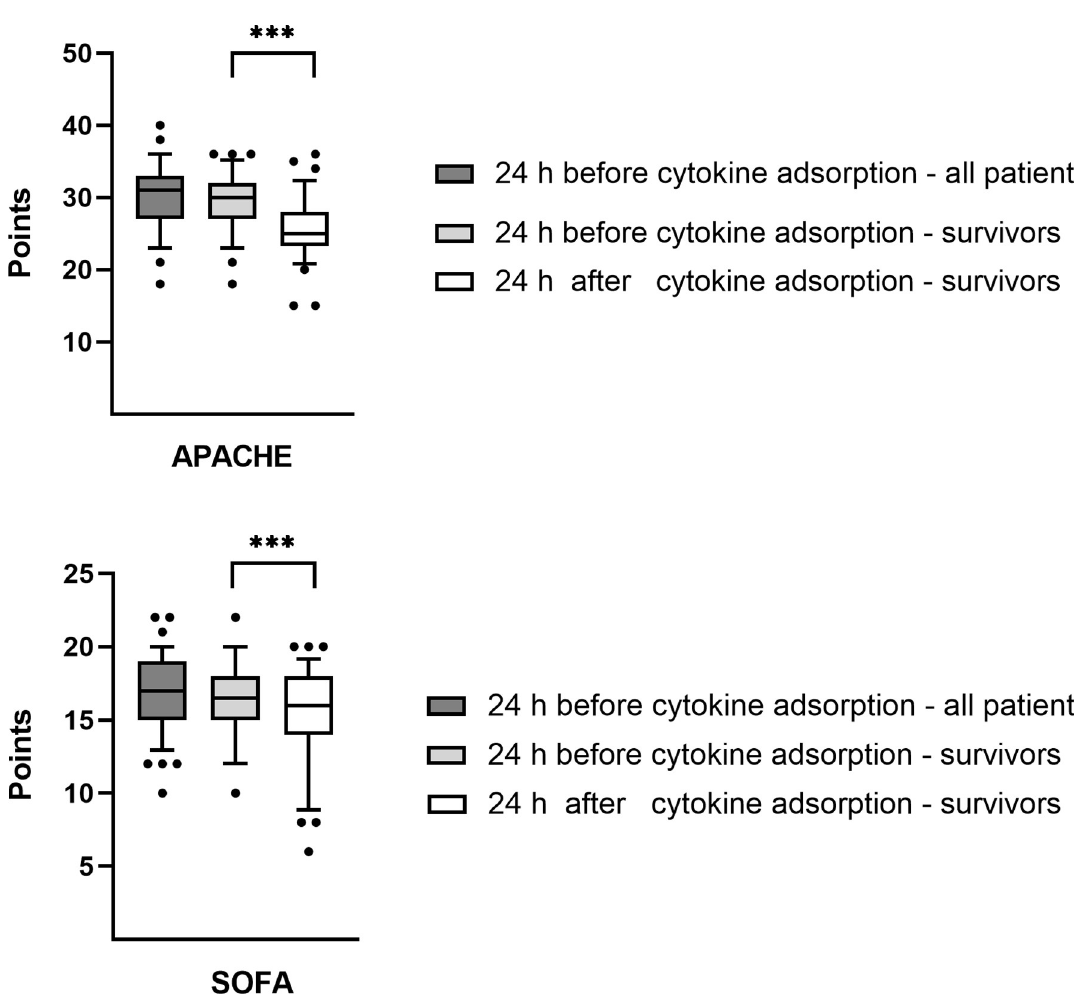
Fig 5. SOFA- score (Fig 5A) and APACHE II-score (Fig 5B) before and after cytokine adsorption. First box shows all n = 98 patients analysed in the study. Second and third box show n = 76 patients who survived longer than 24 hours after cytokine adsorption. Central lines denote median values, and upper and lower borders represent 25th and 75th percentiles. The whiskers represent 5–95 percentile. Highest and lowest values are marked as dots. Asterisks mark differences between both groups at a significance ��� p < 0.001. https://doi.org/10.1371/journal.pone.0246299.g005 SOFA- and APACHE II-score were significantly decreased after cytokine adsorption and the observed in-hospital mortality rate was lower than SOFA- and APACHE II-score predicted mortality rate. In these patients with a predicted very high mortality risk according to Euro- SCORE II, SOFA- and APACHE II-score, extracorporeal cytokine adsorption stabilized hemo- dynamic parameters with an average reduction of VAS by 27.7 points.